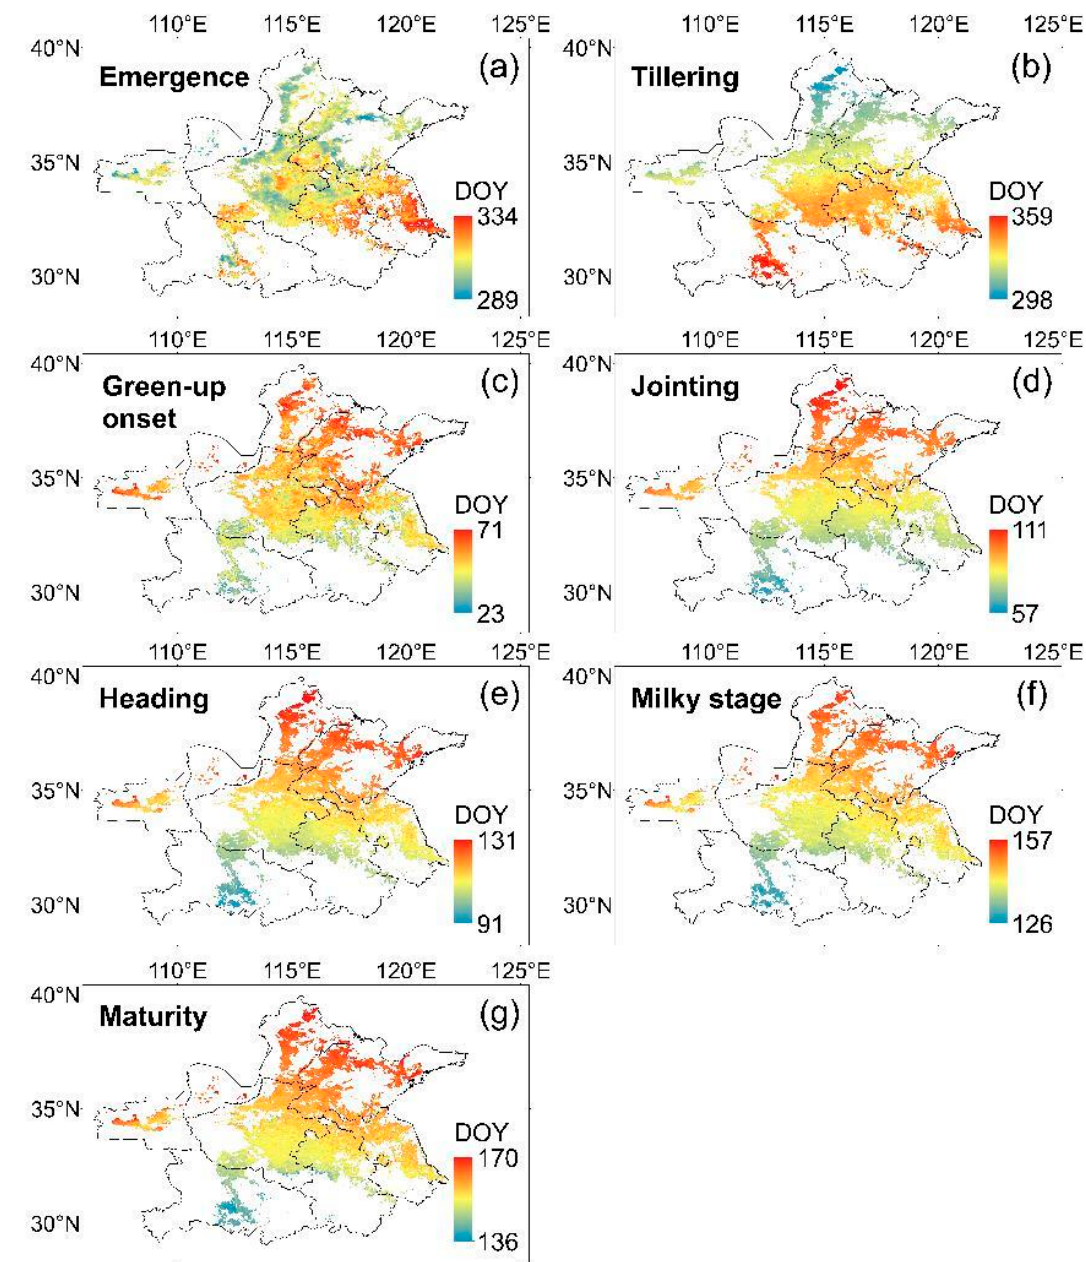
Figure 5. Spatial distribution of multiyear average phenology of winter wheat extracted from VIP data. DOY represents day of year. ( a ) illustrates spatial distribution of multiyear average phenology for emergence, ( b ) illustrates spatial distribution of multiyear average phenology for tillering, ( c ) illustrates spatial distribution of multiyear average phenology for green-up onset, ( d ) illustrates spatial distribution of multiyear average phenology for jointing, ( e ) illustrates spatial distribution of multiyear average phenology for heading, ( f ) illustrates spatial distribution of multiyear average phenology for milky stage, and ( g ) illustrates spatial distribution of multiyear average phenology for maturity, respectively.